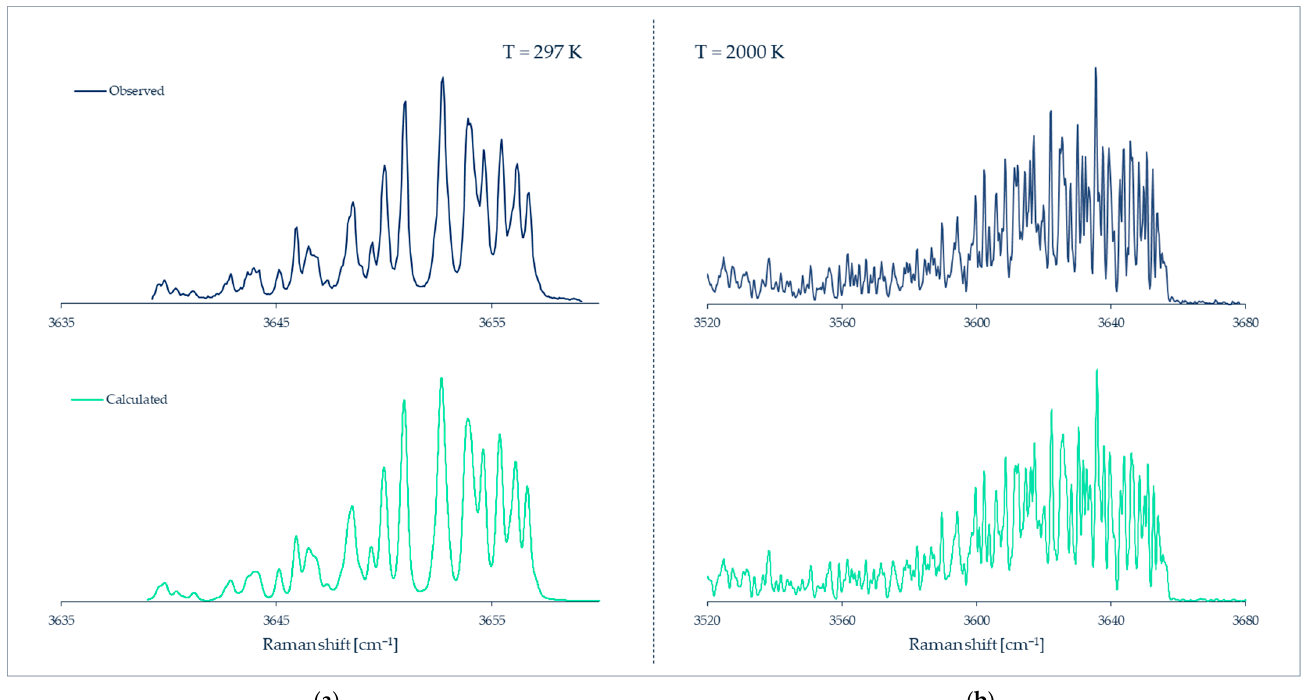
Figure 25. Raman spectra of the OH stretching band of gaseous H 2 O at ( a ) 297 K, and ( b ) ~2000 K, observed and simulated by Avila et al. Data from [ 118 ] .